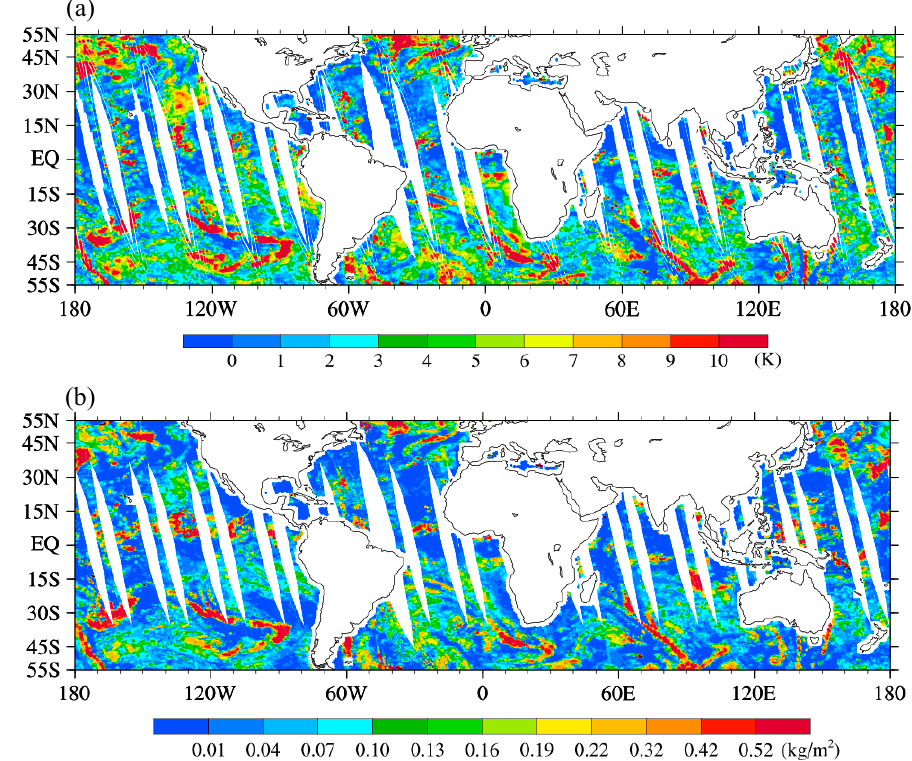
Figure 8. Spatial distributions of ξ O − B for ( a ) FY-3C MWTS-2 channel 1 and ( b ) the liquid water path over areas with overlapping ascending swaths between MWTS-2 and AMSU-A on 15 July 2014.